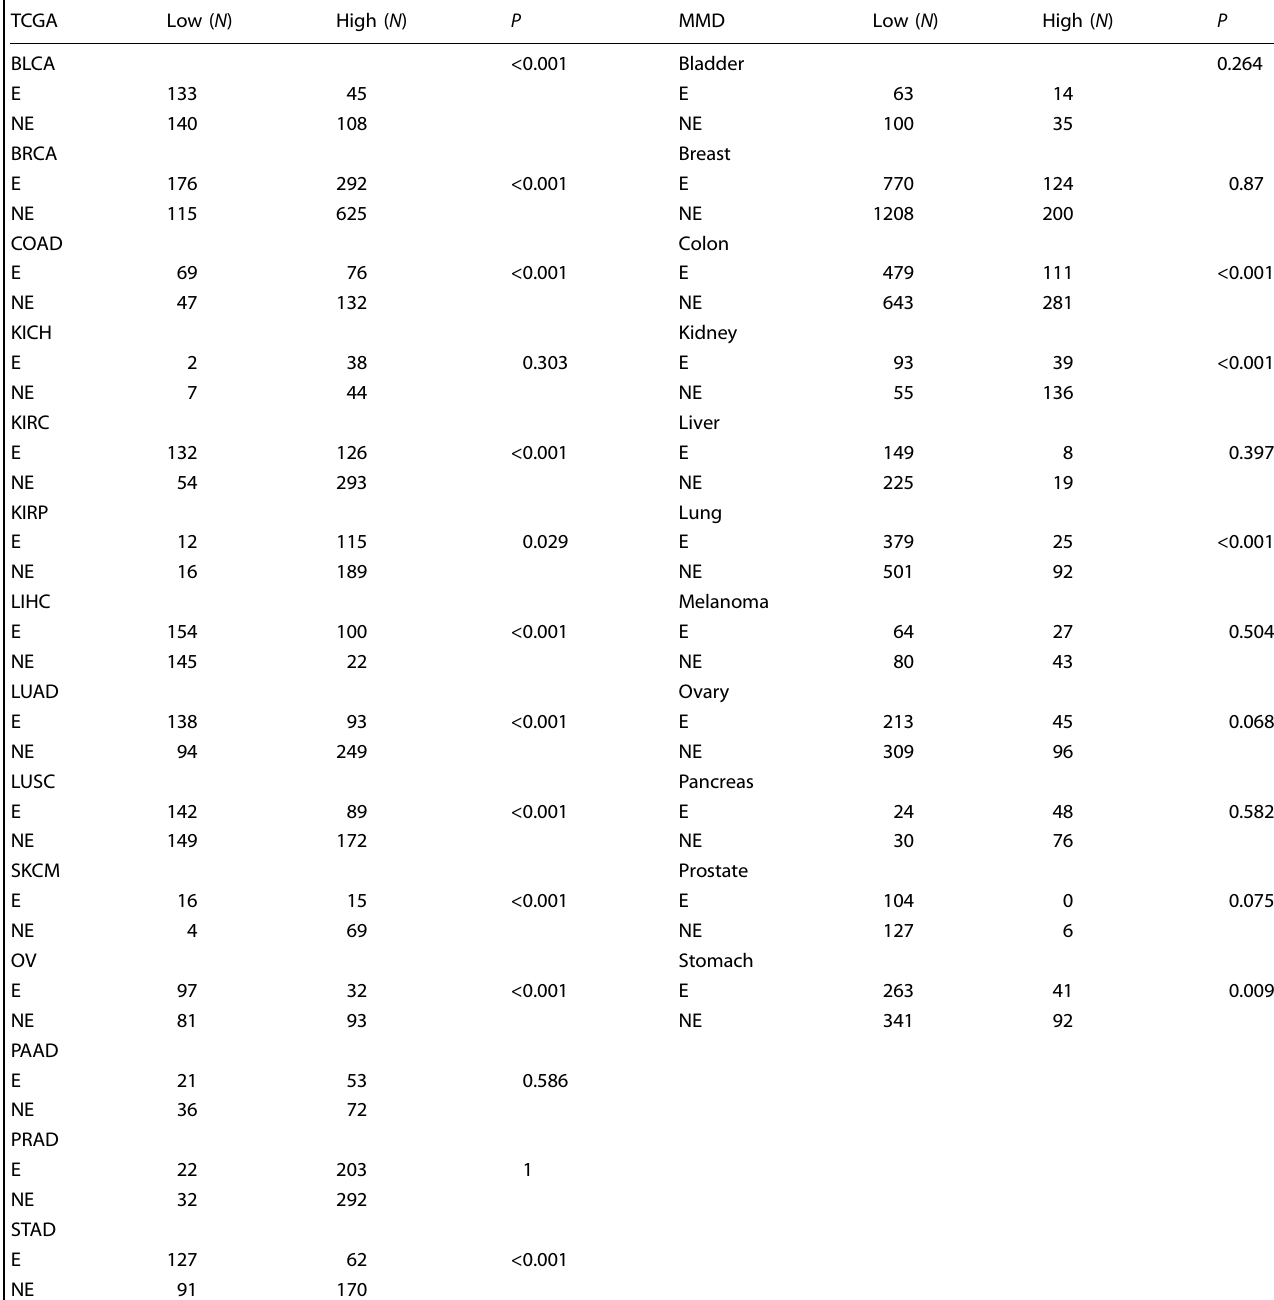
Table 1. Distribution of RSI between TCIA-enrichment and